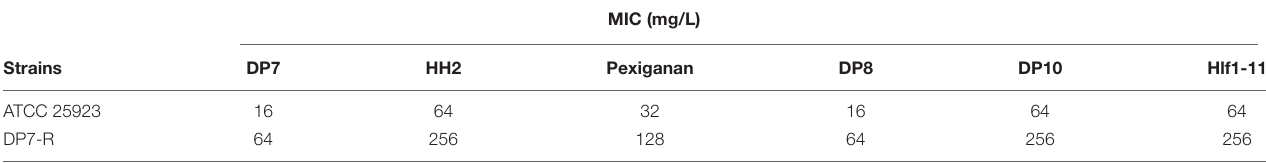
TABLE 5 | Determination of MICs of a variety of antimicrobial peptides in ATCC 25923 and DP7-R.